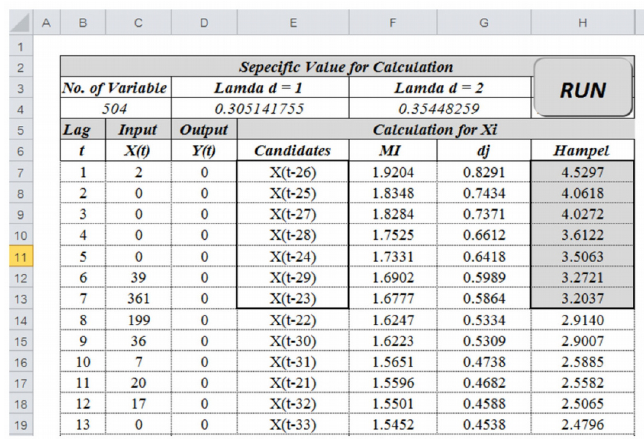
Figure 3. Output screen capture of the input selection